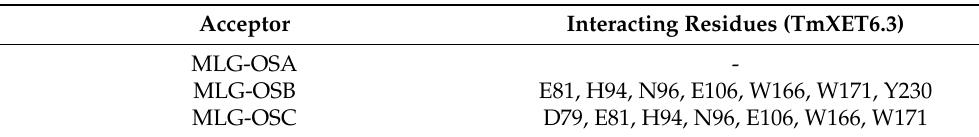
Figure 6. Time dependence of the distance (Å ) between the C1 atom of the XG-OS7 donor and the O4 atom of the MLG-OS acceptors during MD simulations with TmXET6.3. The C1 and O4 atoms form a glycosidic bond. Table 6. The TmXET6.3 residues that interact with MLG-OS acceptors over 50% of MD simulation times at distances of up to 4.0 Å .